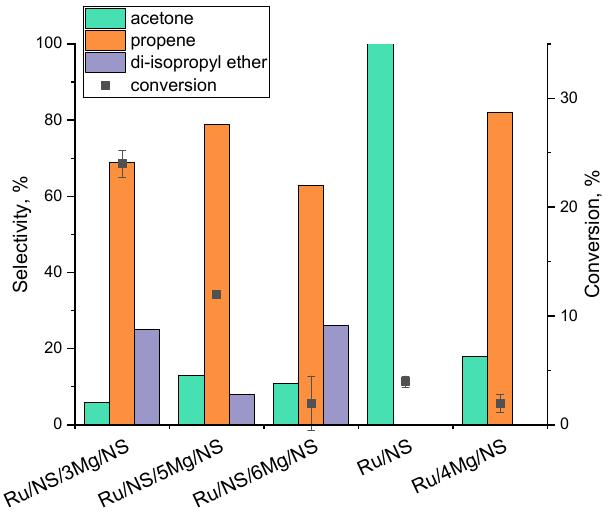
Figure 5. Catalytic results in the reaction of 2-propanol decomposition.